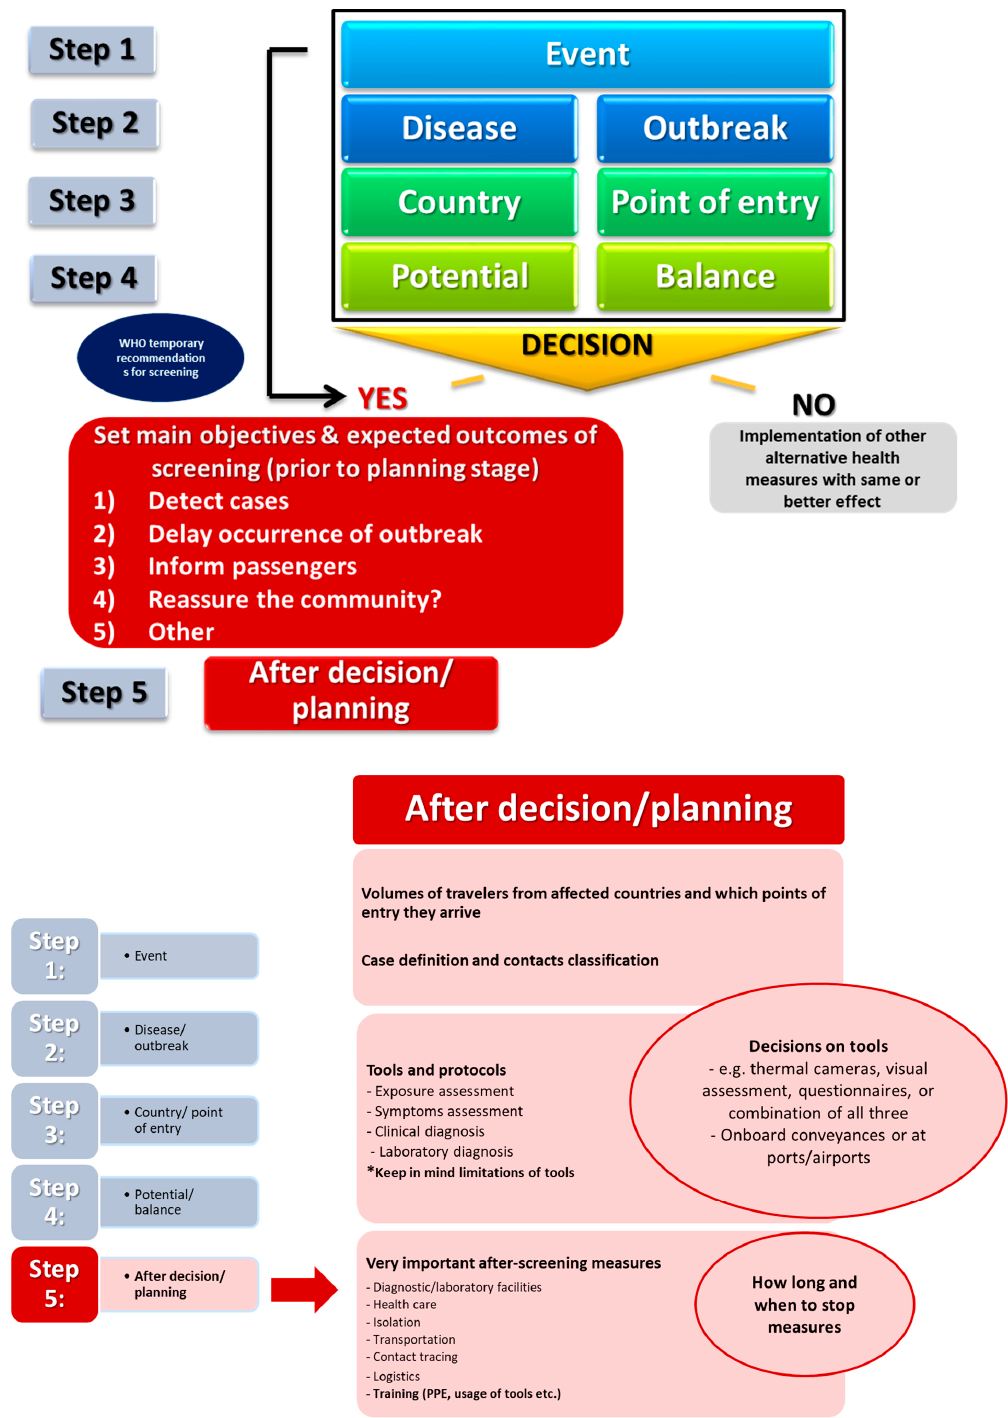
Figure A1. Algorithm for making evidence-based decisions in implementing entry and exit screening measures at points of entry.